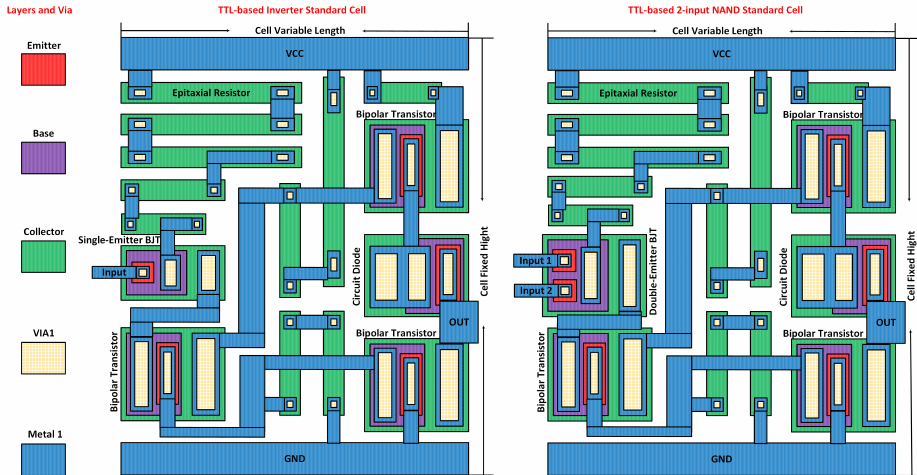
Figure 3. Layout implementation of SiC bipolar TTL-based gate using PDK P-cells as a standard cell. For more dense and ease of integration each cell has a standard height, V CC is routed on the top side and G ND on the bottom side of the standard cell. The inputs are on to the left and outputs on to the right side. ( Left ) An Inverter standard cell illustration using SiC TTL PDK. ( Right ) 2-input NAND standard cell illustration using SiC TTL